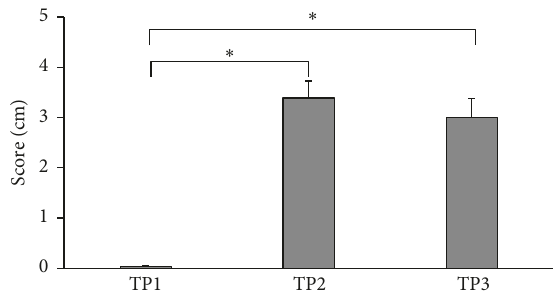
Figure 6: Visual Analog Scale (VAS) scores obtained from all the subjects at three time points. Significant difference ( 𝑝 < 0.05 ) is shown with